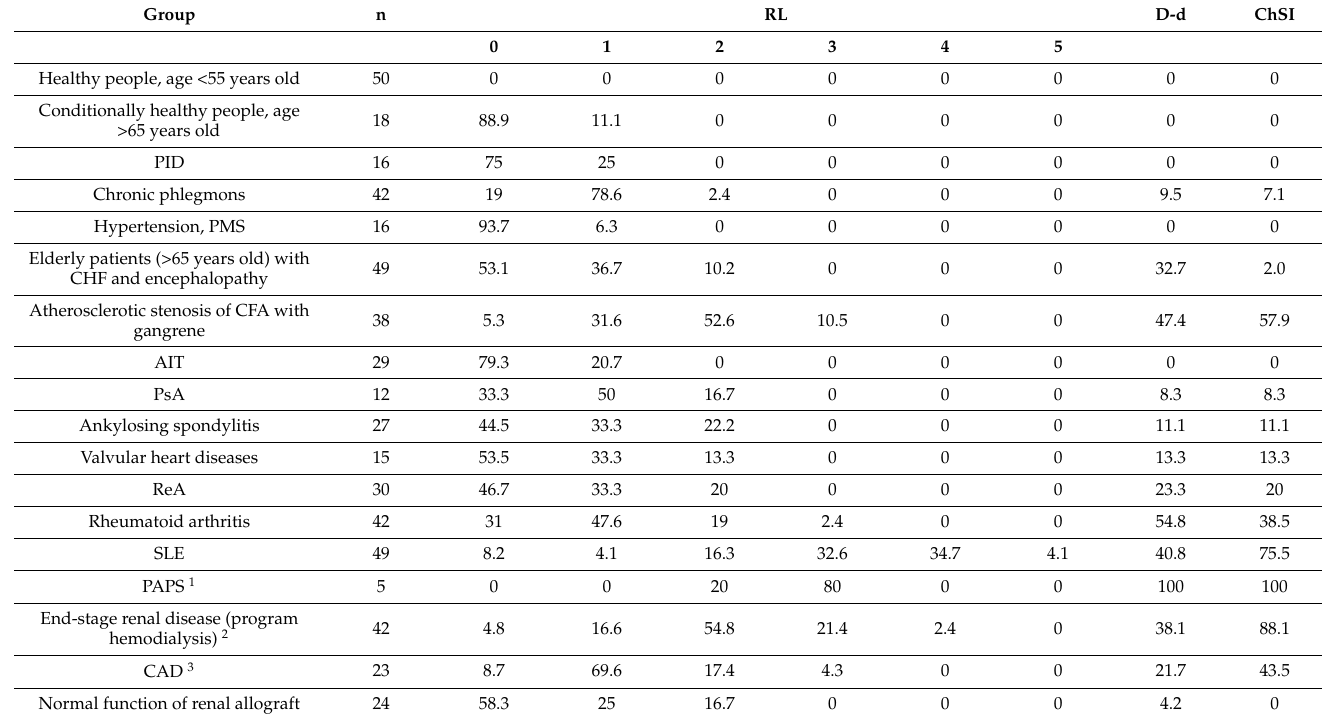
Table 2. The frequency of the values of reactivity level (RL), D-dimer >500 ng/mL (D-d), and ChSI Score (ChSI ≥ 3 points) in chronic diseases